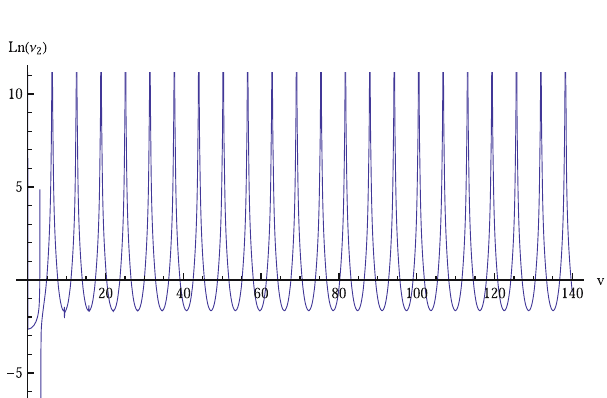
Figure 2: Behavior of ν 1 .